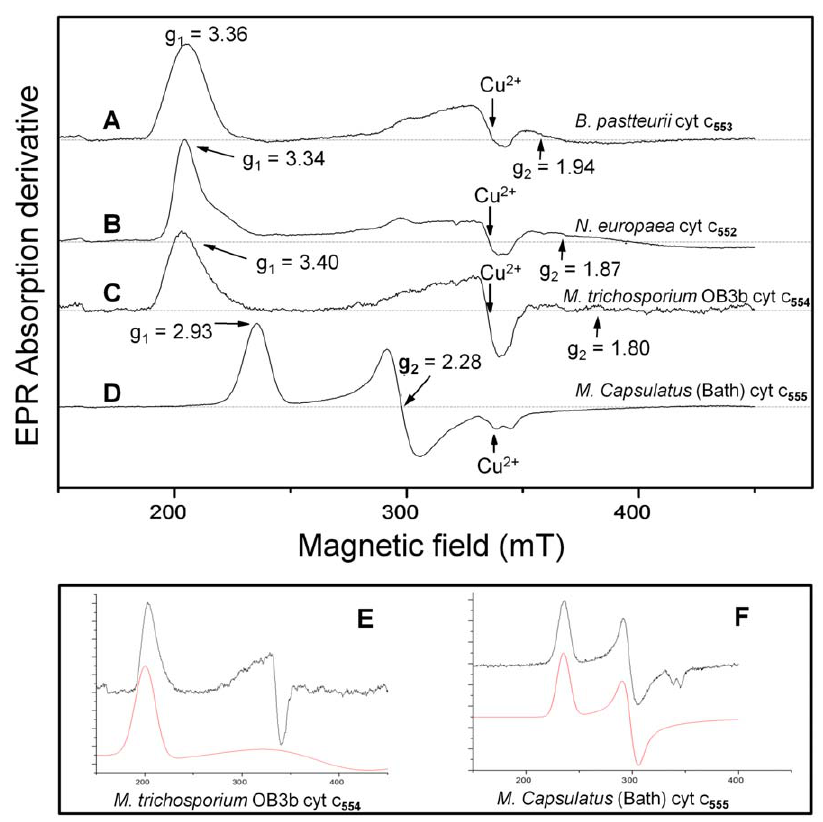
Figure 4. EPR spectroscopy of c-type cytochromes. X-band EPR spectra of cytochromes c from: A. Bacillus pasteurii (cytochrome c -553) [44], B. Nitrosomonas europaea (cytochrome c -552) [44], C. Methylosinus trichosporium OB3b (cytochrome c -554), and D. Methylococcus capsulatus (Bath) (cytochrome c -555). The protein solutions were prepared in 50 mM HEPES buffer at pH 7.5, and the spectra were recorded in perpendicular mode at 10 K with 2 mW microwave power, modulation amplitude 1 mT, modulation frequency 100 kHz, sweep time 168 s, time constant 82 ms and 4 6 10 4 gain. E. Simulation of the HALS EPR spectrum C (red). F. Simulation of the rhombic EPR spectrum D (red).